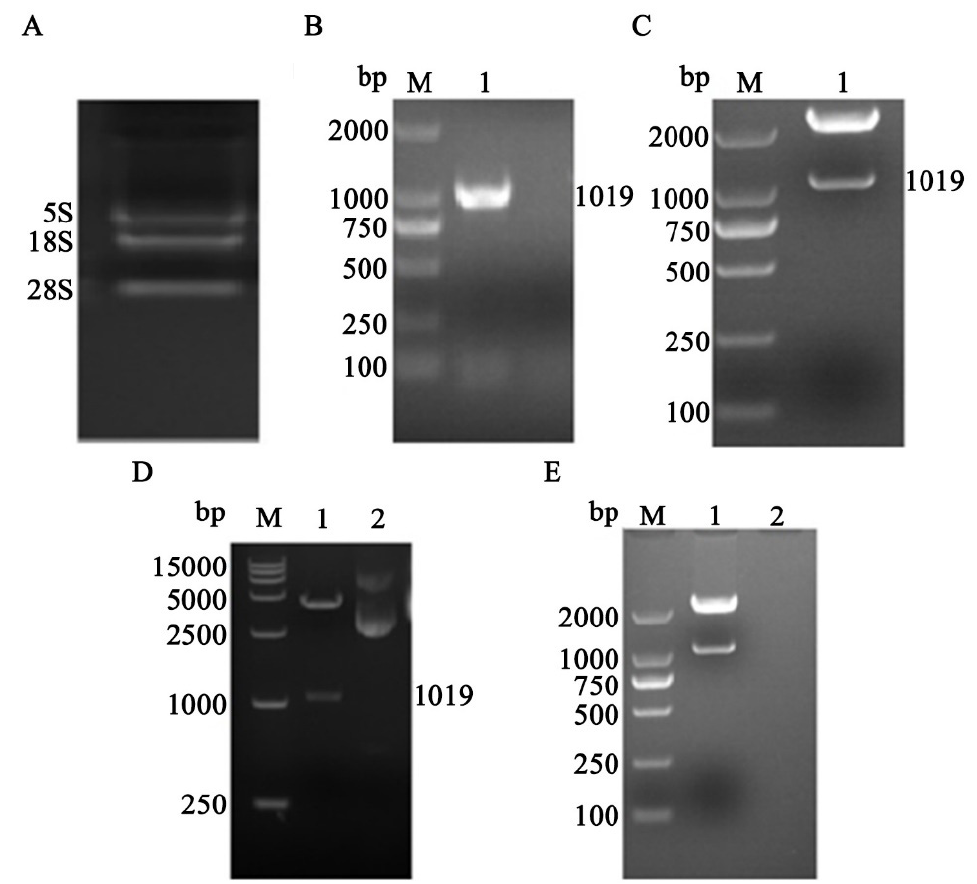
Figure 1. Construction of eukaryotic expression vector of pCMV-EGFP-TGR5 and pCMV-TGR5. ( A ): Total RNA extraction; ( B ): examination of TGR5; ( C ): the identification of pMD19-T-TGR5 by double enzyme cleavage; ( D ): the identification of PCMV-EGFP-TGR5 by double enzyme; ( E ): the identification of pCMV-TGR5 by double-enzyme